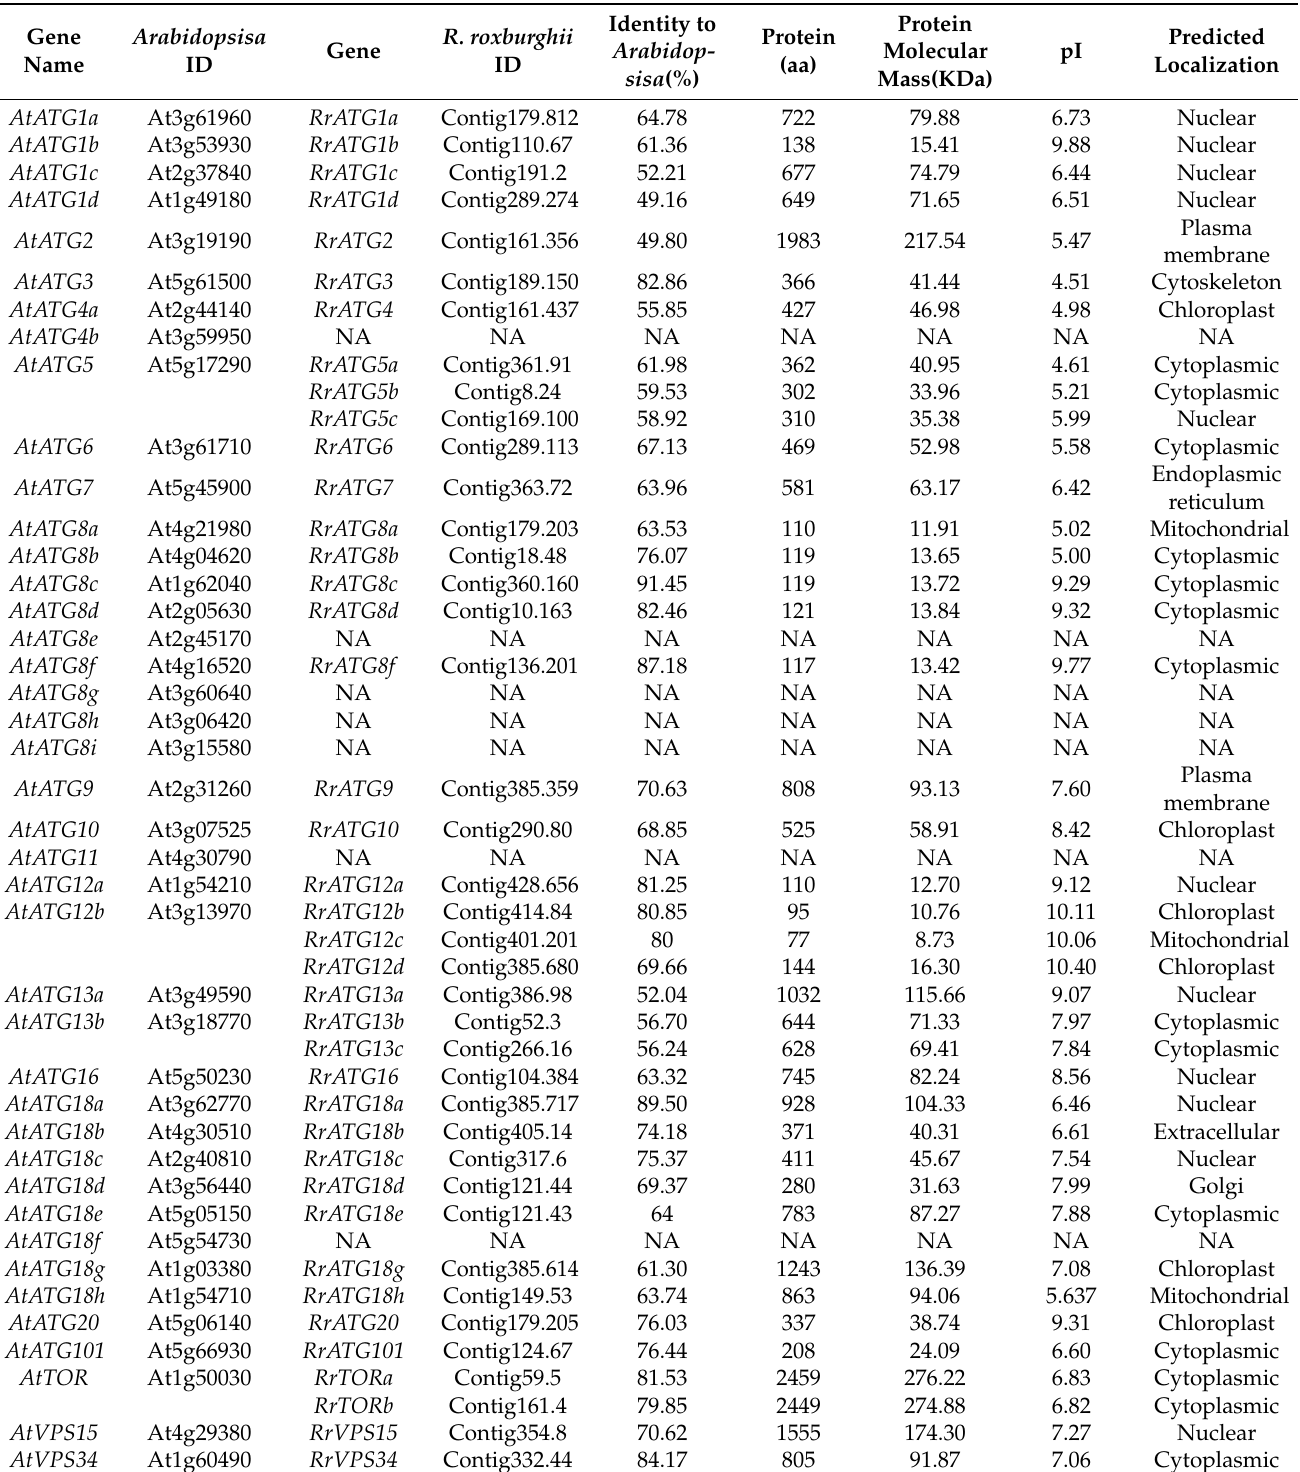
Table 1. Related information of autophagy-related genes (ATGs) in R. roxburghii